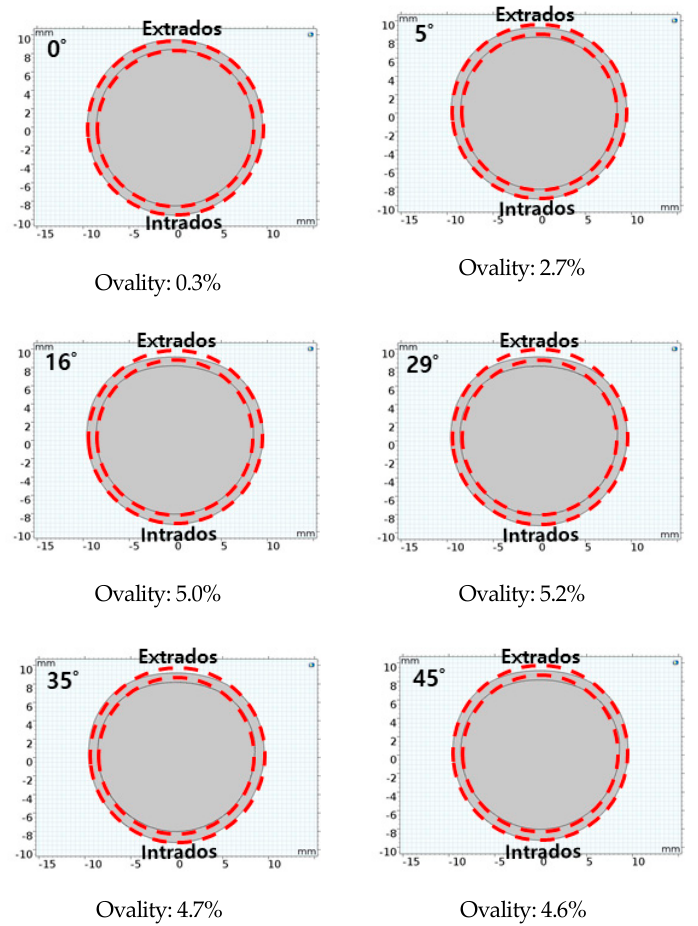
Figure 5. The analysis results for the 2D modeling using the simulation software.